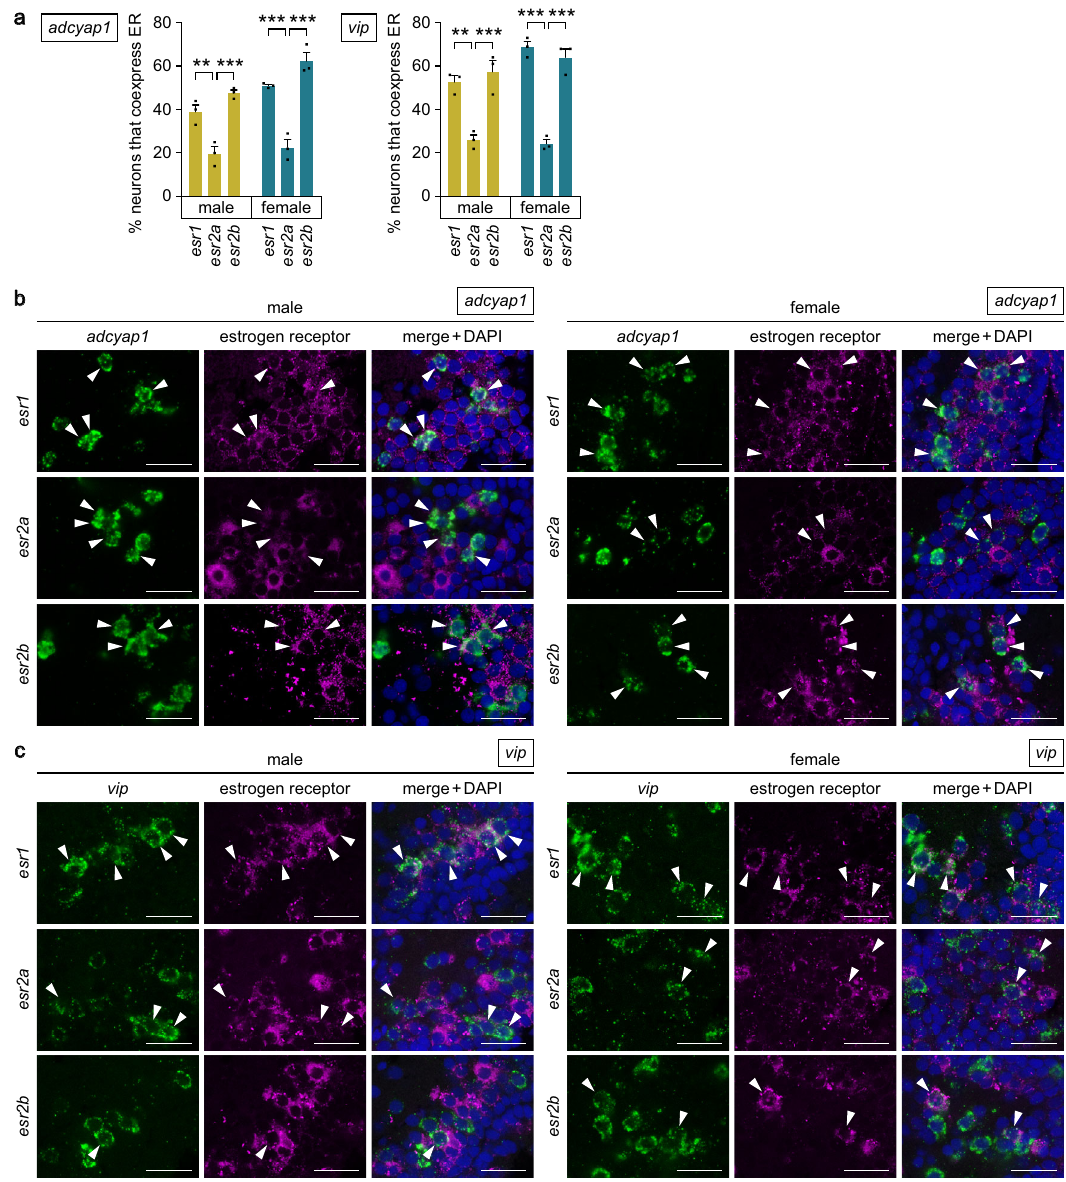
Fig. 5 adcyap1 - and vip -expressing neurons in the POA are direct targets of estrogen. a Percentage of adcyap1 - and vip -expressing neurons in the male and female PMp that co-express estrogen receptors ( esr1 , esr2a , and esr2b ) ( n = 3 fi sh per group). b, c Representative micrographs showing the expression of estrogen receptors in adcyap1 -expressing ( b ) and vip -expressing ( c ) neurons in the male and female PMp. In each row, left and middle panels show images of, respectively, adcyap1 / vip (green) and estrogen receptor (magenta) expression in the same section; right panel shows the merged image with nuclear counterstaining (blue). Arrowheads indicate representative adcyap1 / vip -expressing neurons that co-express estrogen receptor. Scale bars represent 20 μ m. Quantitative data were expressed as means with error bars representing standard error of the mean. Statistical differences were assessed by Bonferroni ’ s post-hoc test ( a ). ** p < 0.01; *** p <